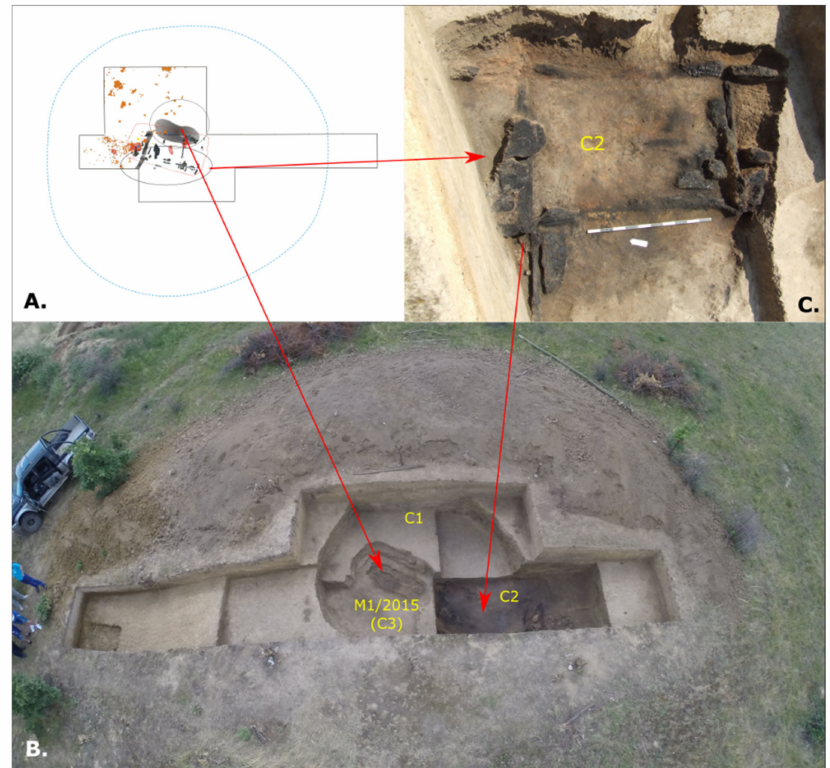
Figure 12. ( A ) The excavation plan presented by Diaconescu 2020 [24]; ( B ) Drone image taken during the archaeological excavation where the C1, C2, and C3 are visible (Photo: InfoHD); ( C ) Depiction of feature C2 after the removal of vitrified clay layer—the preserved beams are coming from the funerary pyre which was cover by the layer 3 (Photo: Dragos ,